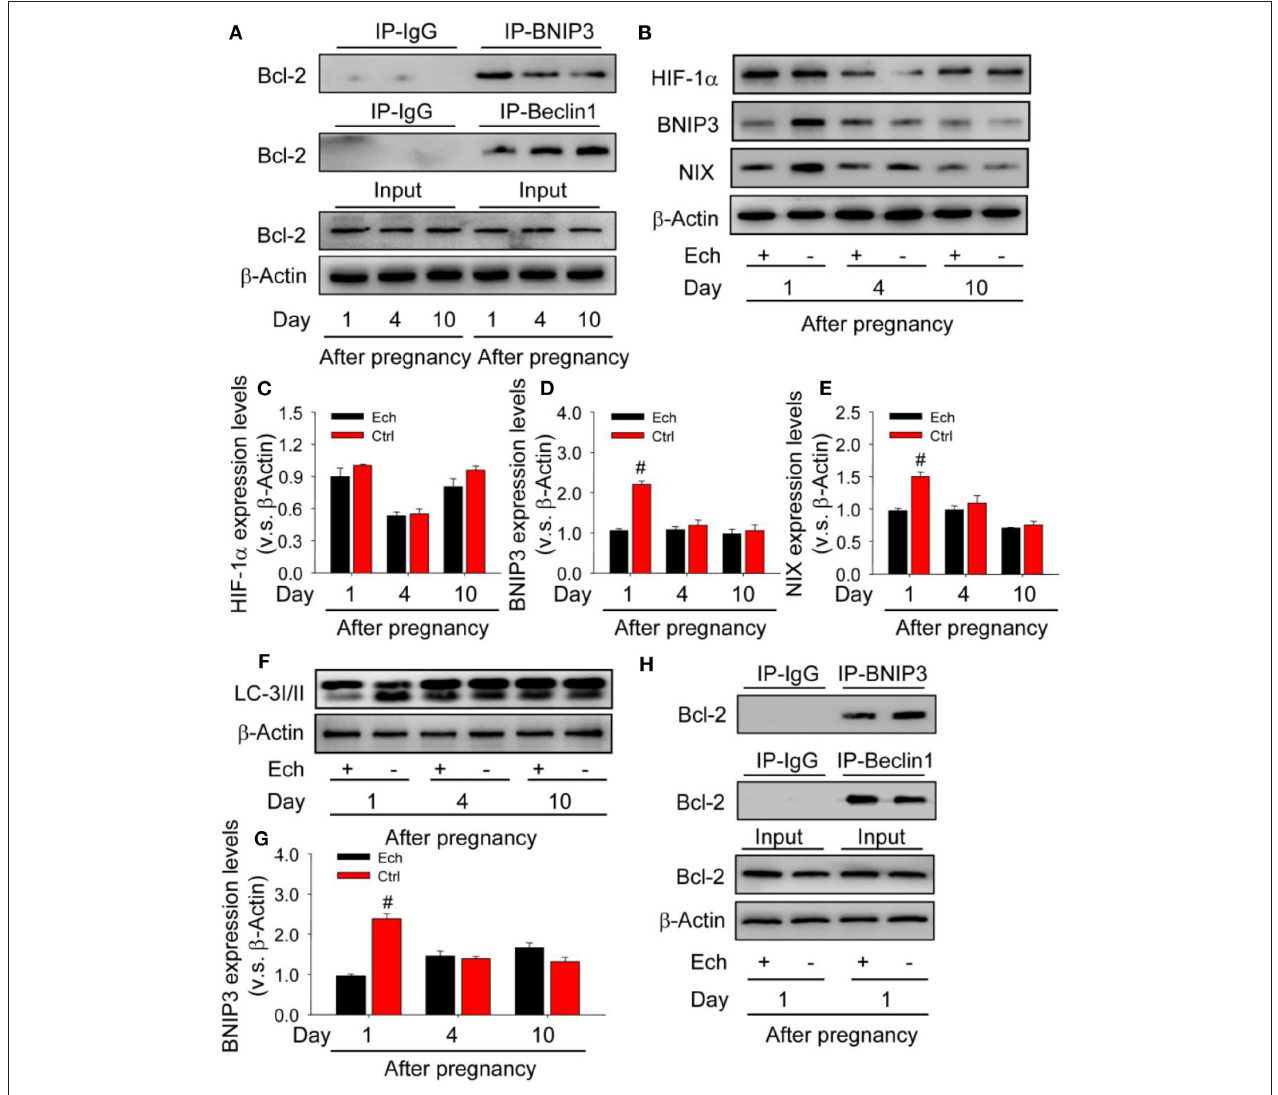
FIGURE 11 | Competitive binding of BNIP3/beclin1 with bcl-2 contributes to the induction of autophagy during the formation of corpus luteum. (A) Expression changes of Bcl-2 in the corpus luteum obtained from the pregnant ovary and homogenized for co-immunoprecipitation with anti-BNIP3 antibody or anti-beclin1 antibody during the development of corpus luteum. (B) Expression changes of HIF-1 α , BNIP3, and NIX proteins in luteal cells during the development of corpus luteum with echinomycin treatment. (C) Summarized intensities of HIF-1 α blotting normalized to the control (Day 1 with echinomycin treatment). (D) Summarized intensities of BNIP3 blotting normalized to the control. (E) Summarized intensities of NIX blotting normalized to the control. (F) Expression changes of LC-3I/II protein in luteal cells during the development of corpus luteum with echinomycin treatment. (G) Summarized intensities of LC-3I/II bloting normalized to the control. (H) Expression changes of Bcl-2 in the corpus luteum obtained from the pregnant ovary and homogenized for co-immunoprecipitation with anti-BNIP3 antibody or anti-beclin1 antibody during the formation of corpus luteum (Day 1 after pregnancy). Each value represents the mean ± SE. One-way analysis of variance (ANOVA) was used to analyze the data, followed by a Tukey’s multiple range test. n = 6. Ech, echinomycin, # P < 0.05, vs. the group in